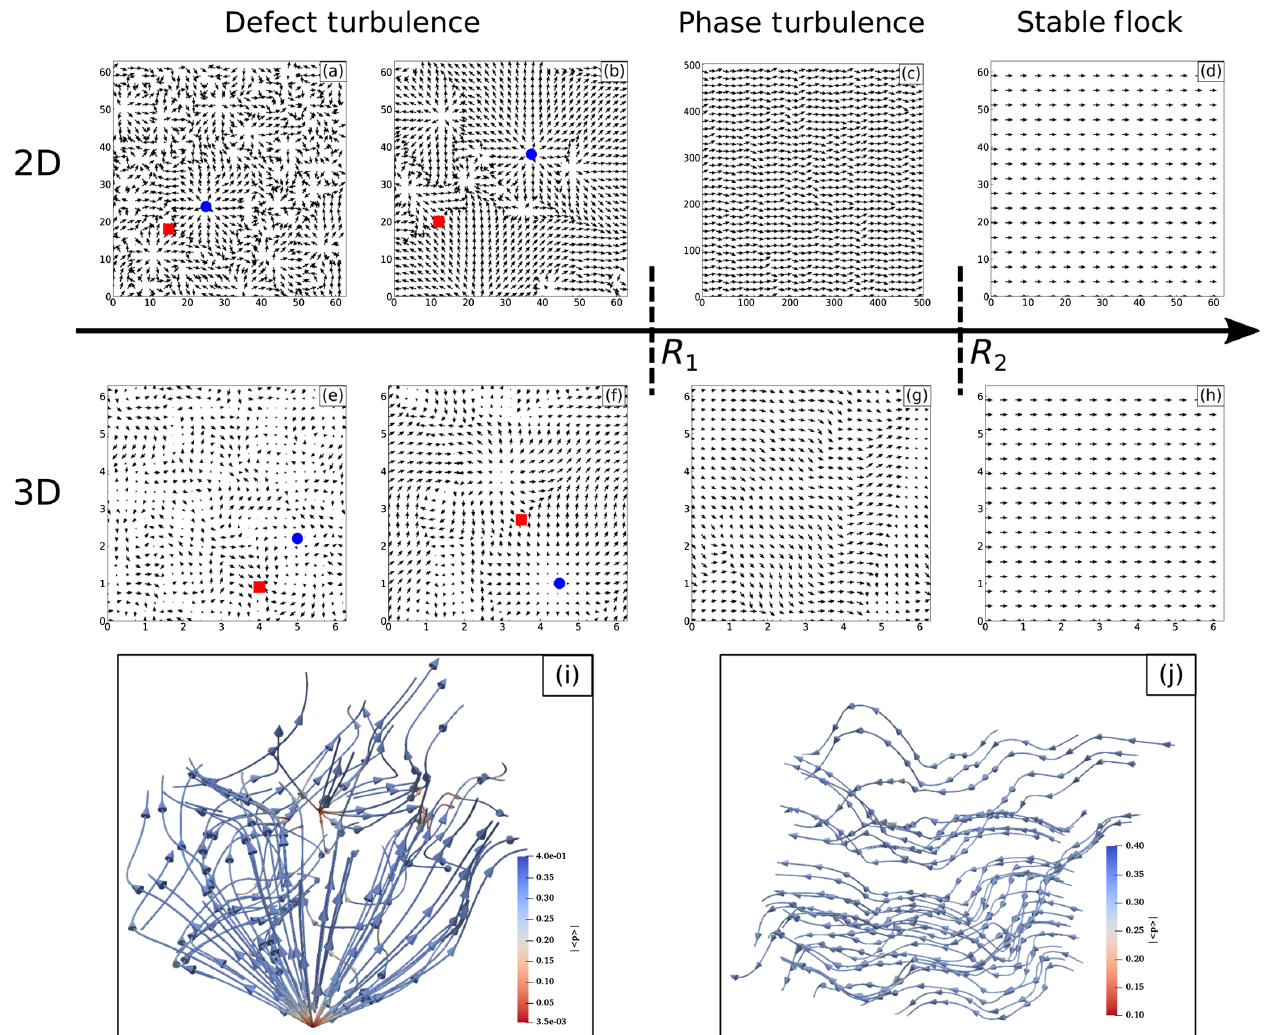
FIG. 4. Increasing interdefect distance as a function of R . Order parameter streamlines for 2D (runs SPP4, SPP6, and SPP9): (a) R ¼ 0 . 1 , (b) R ¼ 0 . 25 , (c) R ¼ 8 , and (d) R > 12 ; streamlines in y ¼ 0 plane for 3D (runs SPP1 and SPP3): (e) R ¼ 0 . 02 , (f) R ¼ 0 . 0625 , (g) R ¼ 1 . 25 , and (h) R > 12 . Typical hedgehogs are marked with filled black circles, and red squares indicate saddles. (i) Enlarged view of the three-dimensional order parameter streamlines showing the complex patterns between a hedgehog-saddle- hedgehog configuration in (f). (j) Three-dimensional nearly ordered configuration in the phase-turbulent regime in